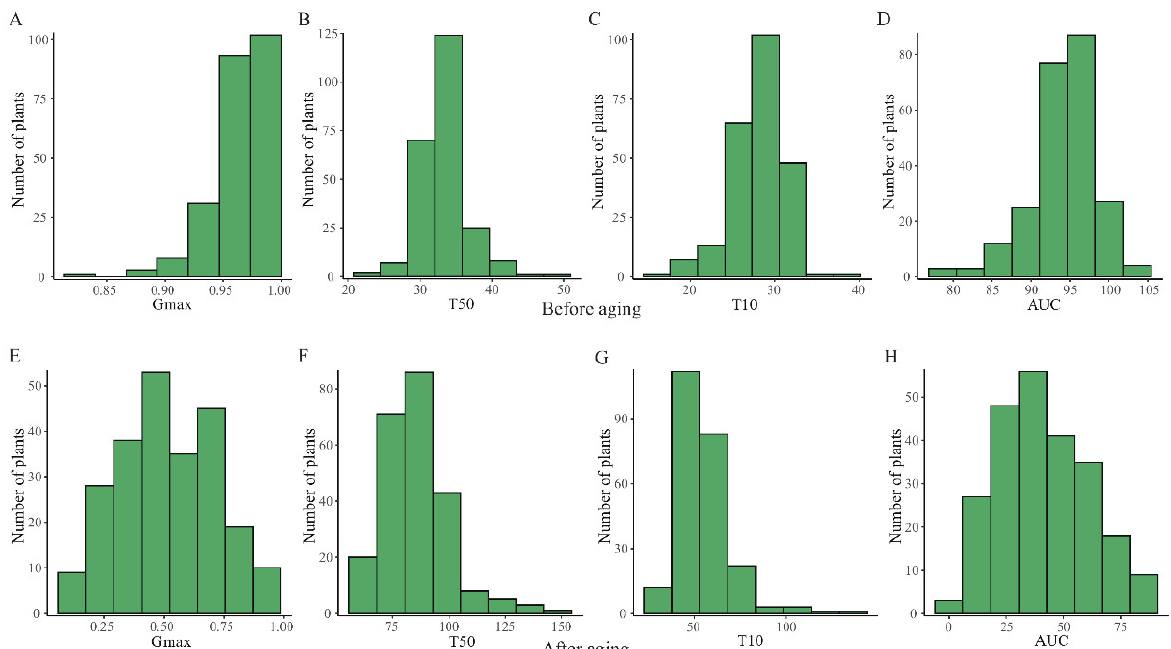
Figure 2. Frequency distribution of the germination parameters before and after artificial aging of the CSSLs population. ( A ) Distribution map of Gmax before artificial aging, ( B ) Distribution map of T50 before artificial aging, ( C ) Distribution map of T10 before artificial aging, ( D ) Distribution map of AUC before artificial aging, ( E ) Distribution map of Gmax after artificial aging, ( F ) Distribution map of T50 after artificial aging, ( G ) Distribution map of T10 after artificial aging, ( H ) Distribution map of AUC after artificial aging.